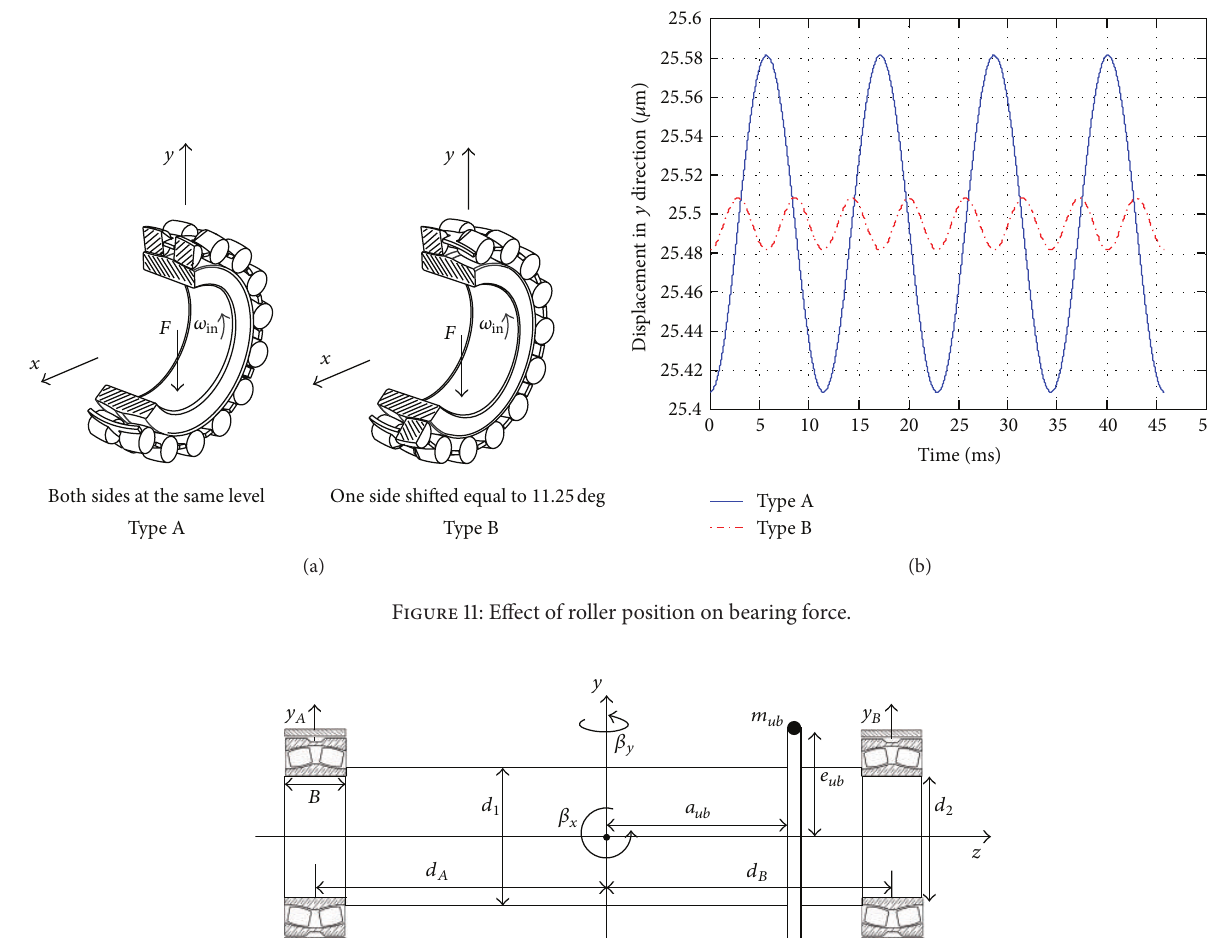
Figure 12: Rigid rotor supported with two spherical roller